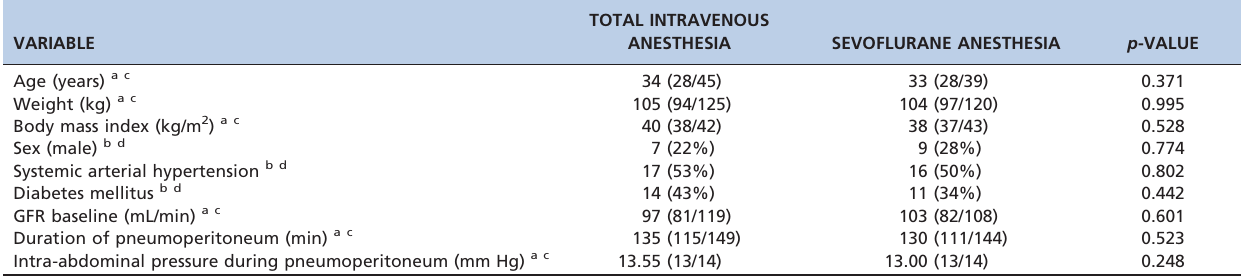
Table 1 - Demographic data according to the anesthesia type (32 patients in each group).